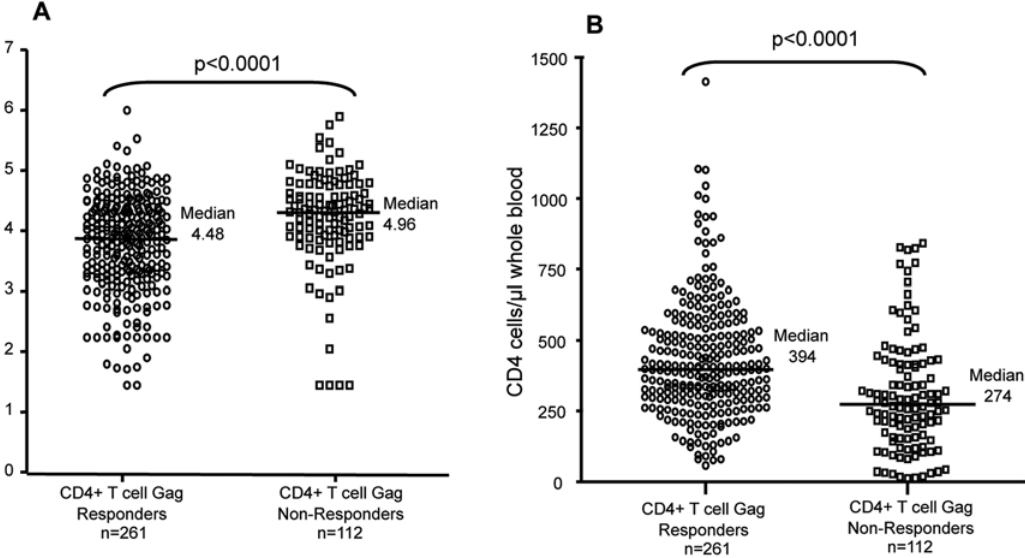
Figure 1. CD4 + T cell responses targeting HIV Gag are associated with immunological control. Persons with a CD4 + T cell response against a pool of Gag peptides have significantly lower viral loads and higher CD4 counts than those with no response against the Gag peptide pool. A total of 373 subjects were screened and statistics were calculated using the Mann Whitney test.